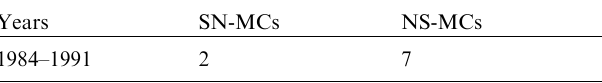
Table 3. Frequencies of SN- and NS-MCs at Earth’s orbit during 1984–1991. The dates and types of the individual MCs are given below the